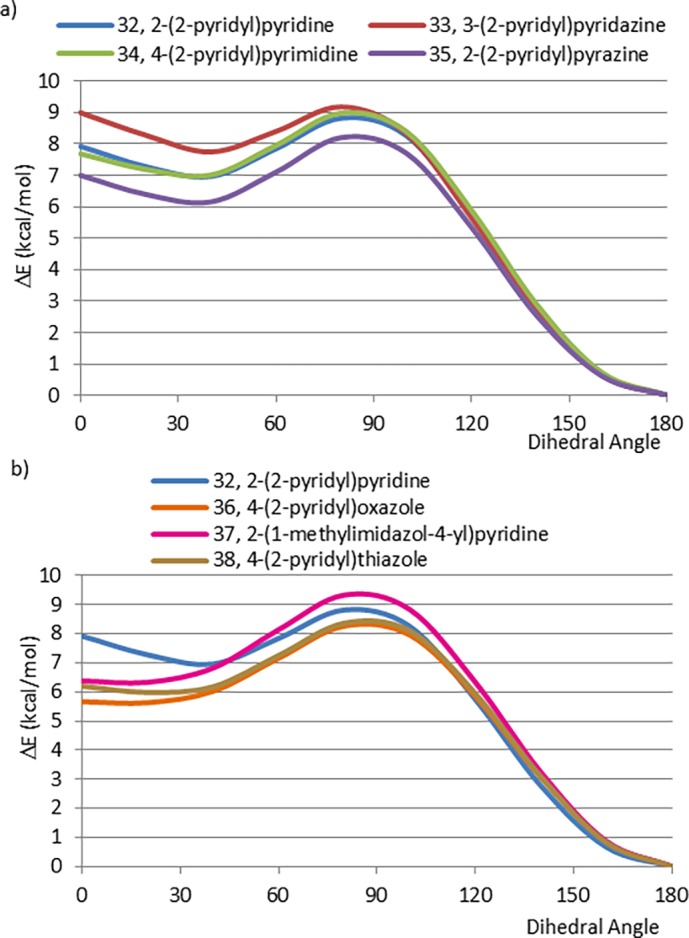
a) CEPs of (6, 6)-pyridyl biaryls, b) CEPs of (5, 6)-pyridyl biaryls.